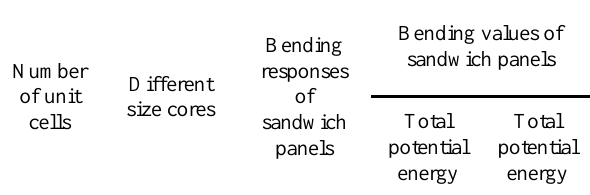
responses sandwich panels